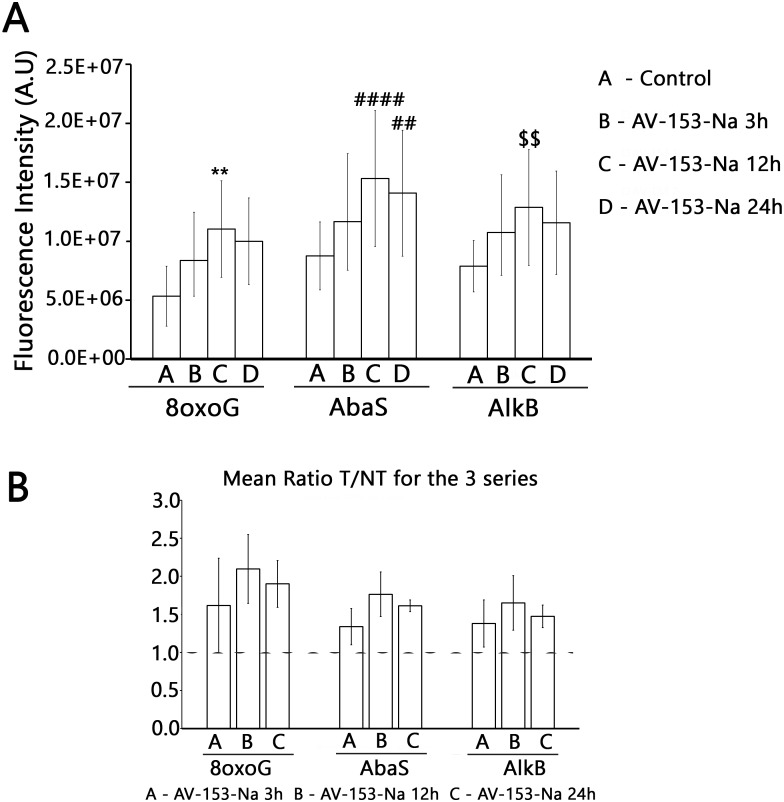
Effect of AV-153-Na on cellular Excision/Synthesis Repair (ExSy-SPOT assay) of major base lesions.The repair reaction was conducted with nuclear extracts prepared from non-treated cells and cells treated for 3 h, 12 h and 24 h with AV-153-Na (see Materials and Methods). For each lesion, we calculated the ratio of the fluorescence intensity obtained with the treated cells over the fluorescence intensity obtained with the control cells. The values >1 reflect an induction of the Excision/Synthesis Repair activities. ∗∗p < 0.01 versus 8oxoG control; ####p < 0.0001 versus AbaS control; ∗p < 0.01 versus AlkB control.